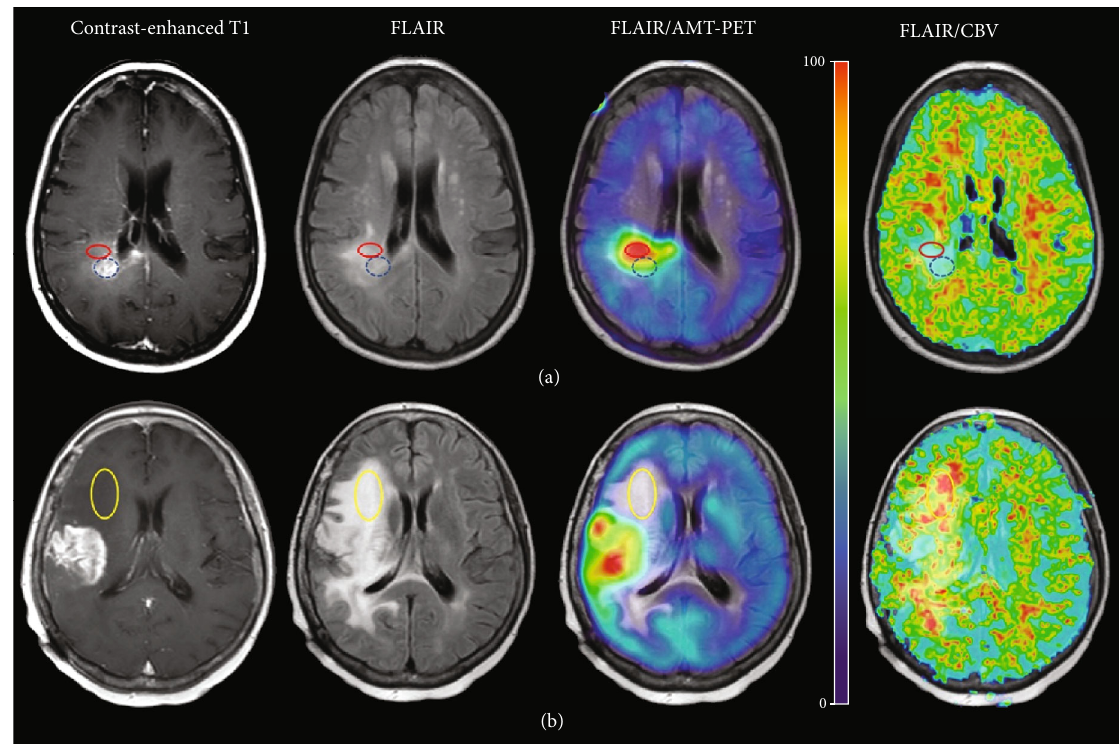
Figure 7: Spatial mismatch between AMT PET uptake and relative cerebral blood volume (CBV) on PWI. Examples of 11 C-alpha-methyl-L- tryptophan (AMT) and relative cerebral blood volume (rCBV) mismatch in patients with newly diagnosed (a) and recurrent (b) glioblastoma. (a) In patient #6, high AMT uptake (AMT tumor to normal [T/N] ratio: 2.78) was associated with low rCBV values (T/N ratio: 0.88) (red circles) adjacent to the contrast-enhancing tumor mass (blue dashed circles). (b) In patient #15, low AMT uptake (T/N ratio: 0.54) was associated with increased rCBV values (T/N ratio: 1.60) in the extensive fl uid-attenuated inversion recovery (FLAIR) hyperintense area surrounding the contrast-enhancing tumor mass with high-AMT uptake (yellow circle). The color bar shows a relative scale (0%-100%). Reproduced with permission from Figure 3 of John et al.